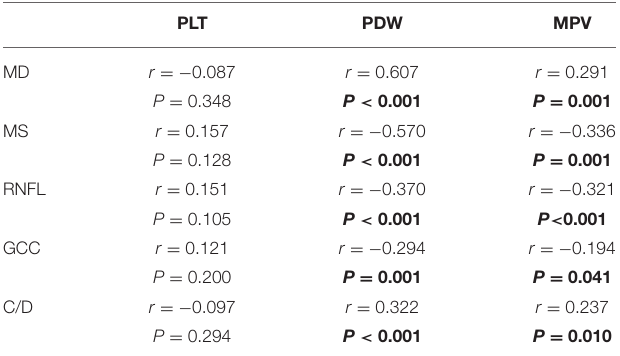
TABLE 3 | Correlation between platelet parameters and ocular parameters in POAG.